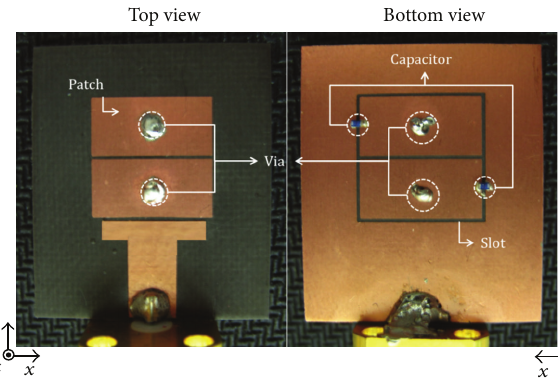
Figure 3: Picture of the fabricated antenna prototype: top and bottom